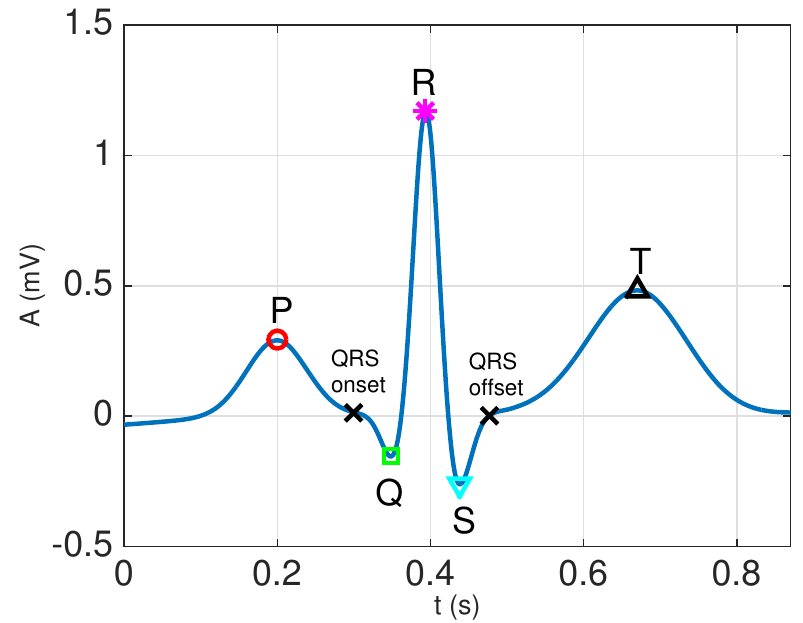
Figure 1. Example of a clean P-QRS-T cycle, with the peaks of all the relevant waveforms